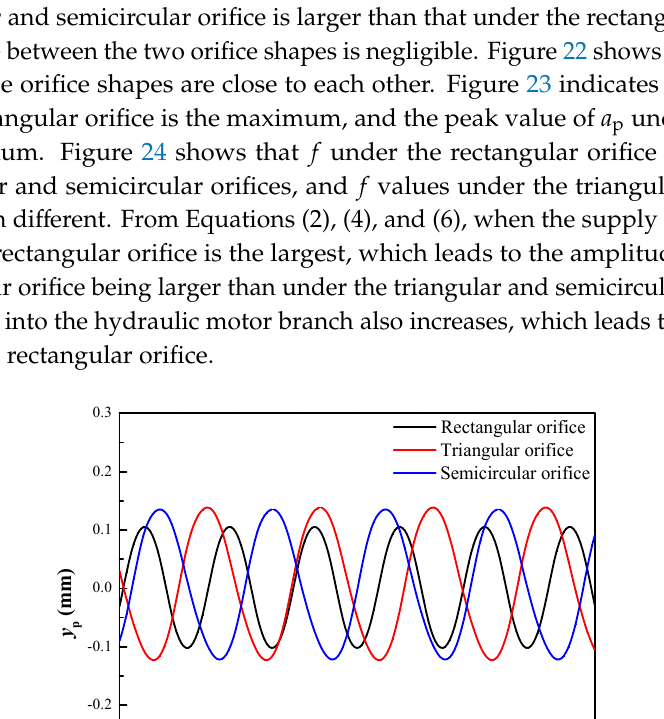
Figure 20. Reversing frequencies of different orifice numbers.